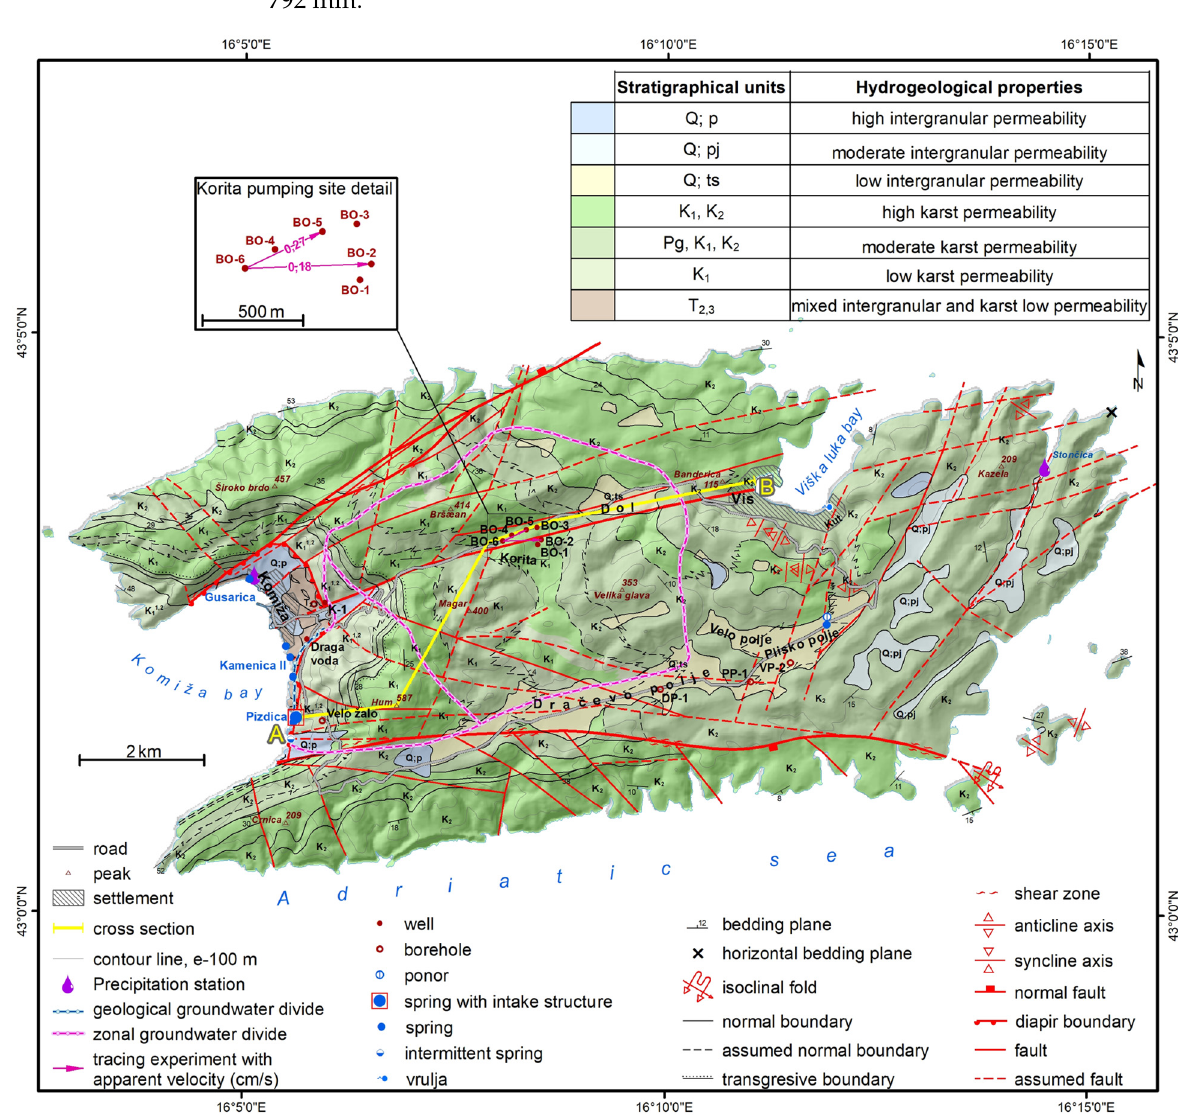
Figure 4. Hydrogeological map of Vis Island (based on the geological map by Korbar et al. [19]). The climate of the research area can be classified as: (i) group: